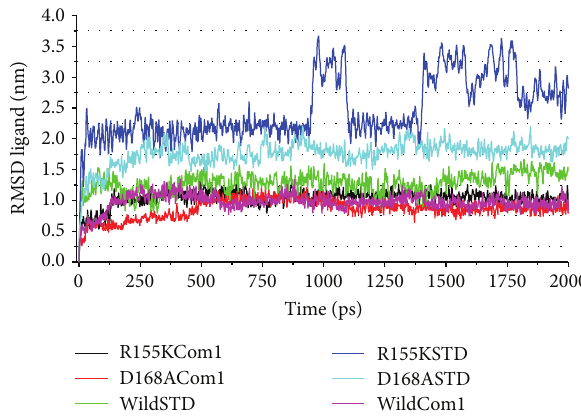
Figure 5: Temperature equilibration of the ligand-protein systems. As can be seen from the plots, the systems for all the ligand- protein complexes readily attained the temperature set at 300 K and maintained it throughout the simulation period. (Note: Asunaprevir is mentioned as STD and Andrographolide as Com 1.)